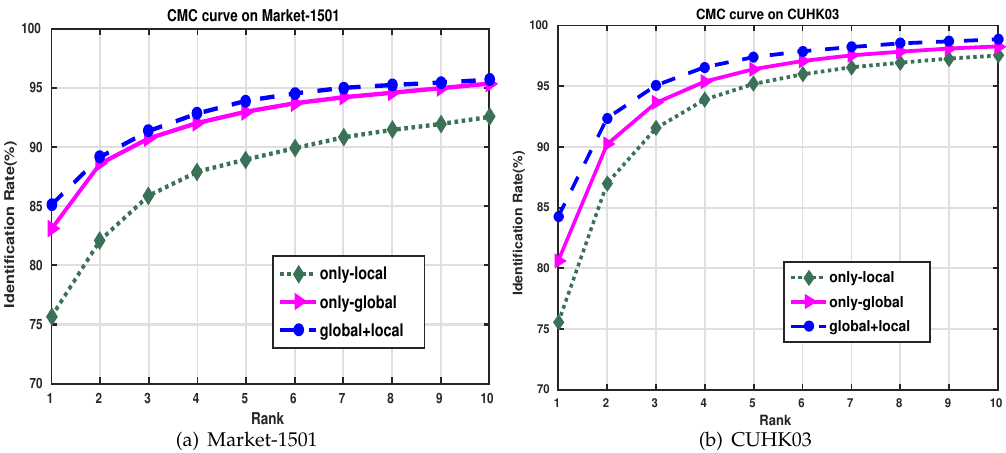
Figure 7. CMC curves on Market-1501 and CUHK03 when using local, global and hybrid features (global+local) extracted by DJL-S (based on InceptionNet).